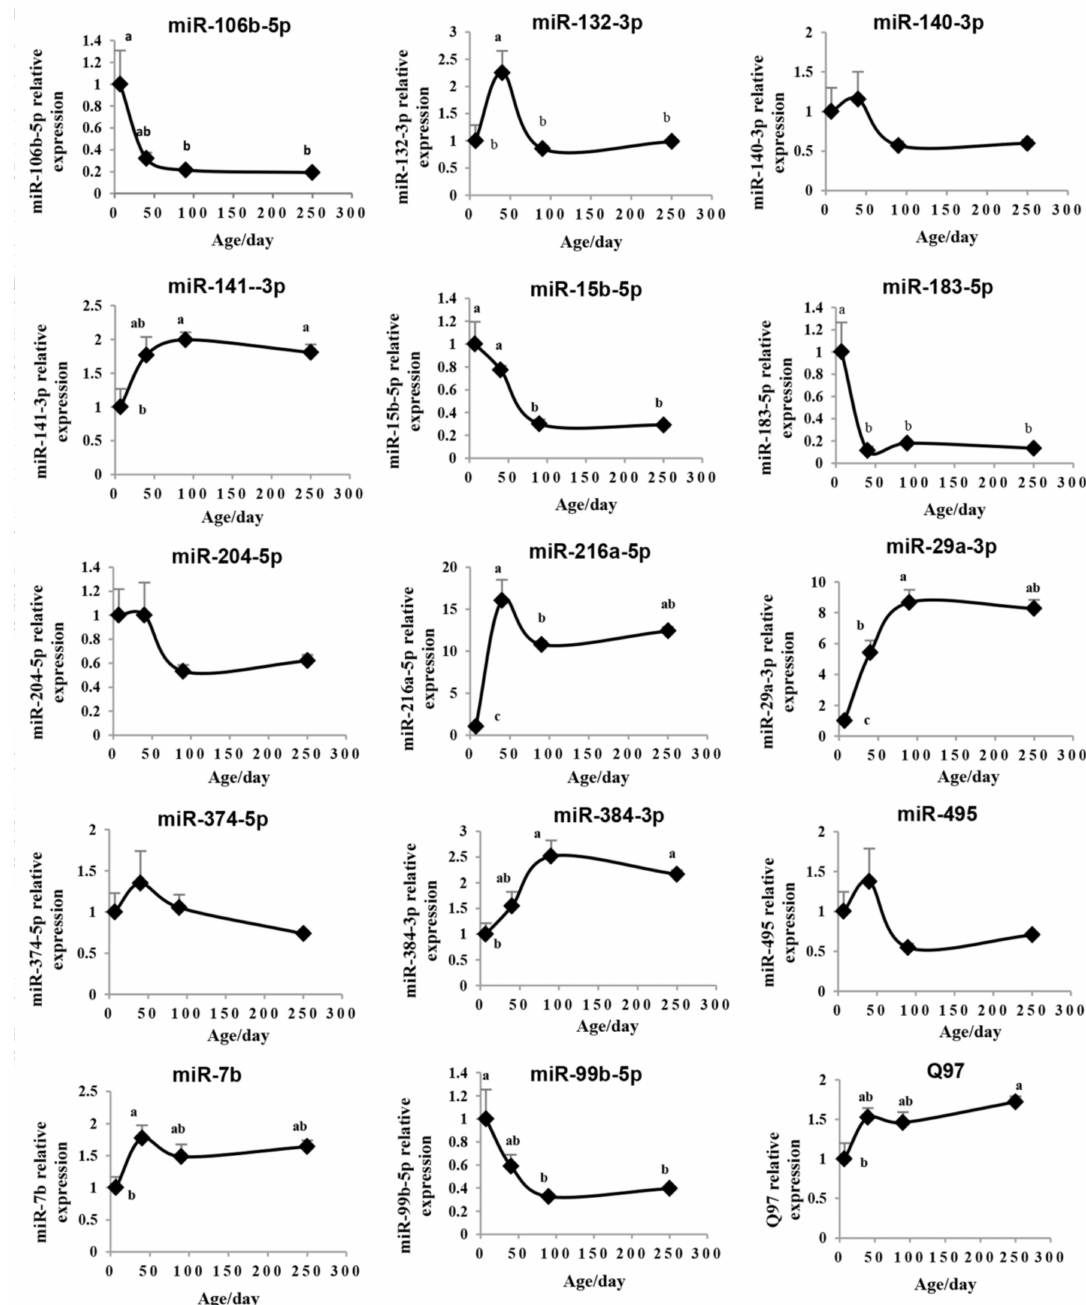
Figure 4. QRT-PCR detection of the temporal expression patterns of the candidate miRNAs. The expressions of 15 miRNAs on rat pituitaries of different ages (Day 7, Day 40, Day 90, and Day 250) were detected by qRT-PCR. The values are expressed as the means ± SEM. Means with different letters were significantly different ( n = 8; p < 0.05; ANOVA;